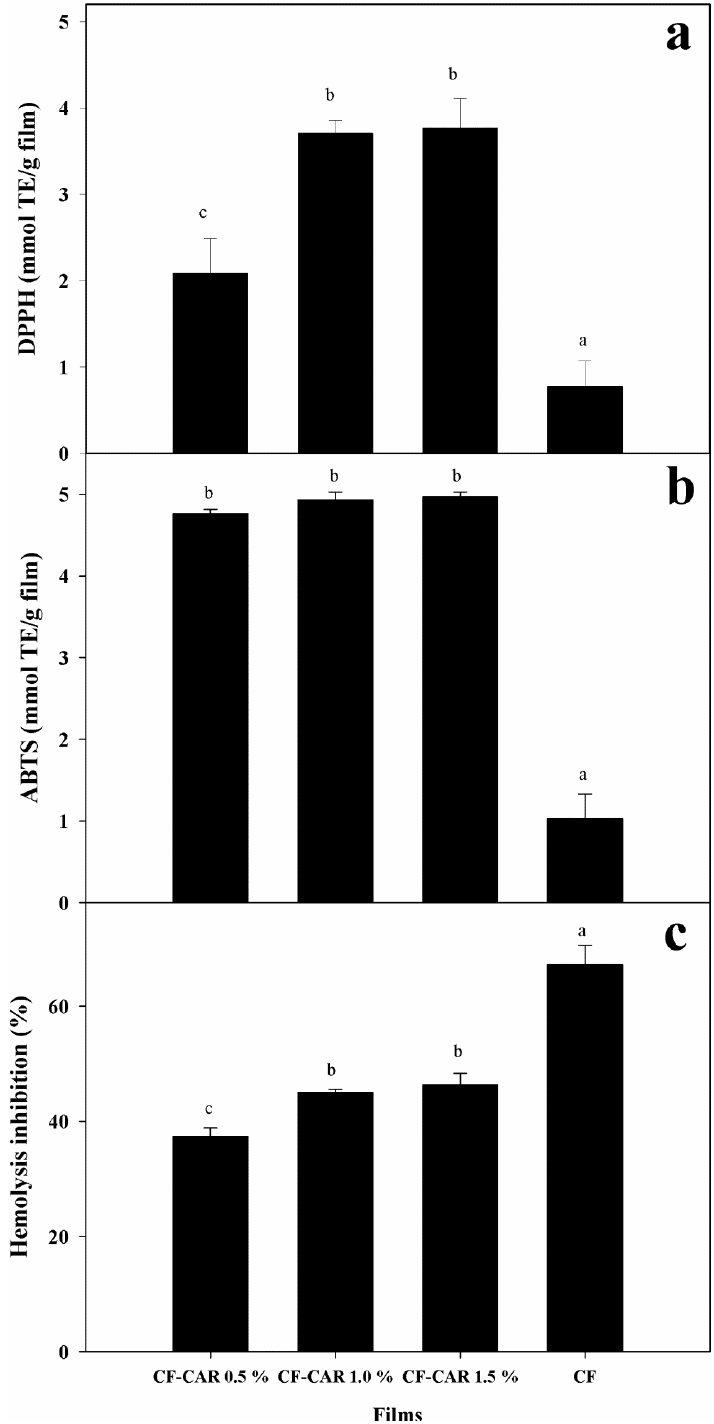
Figure 4. Antioxidant capacity of films extract determined by DPPH ( a ), ABTS radicals ( b ) and percentage of hemolysis inhibition ( c ). The data are the mean values of at least three determinations. The mean values represented by the bars for each type of films extract that are indicated with a different letter are significantly different ( p ≤